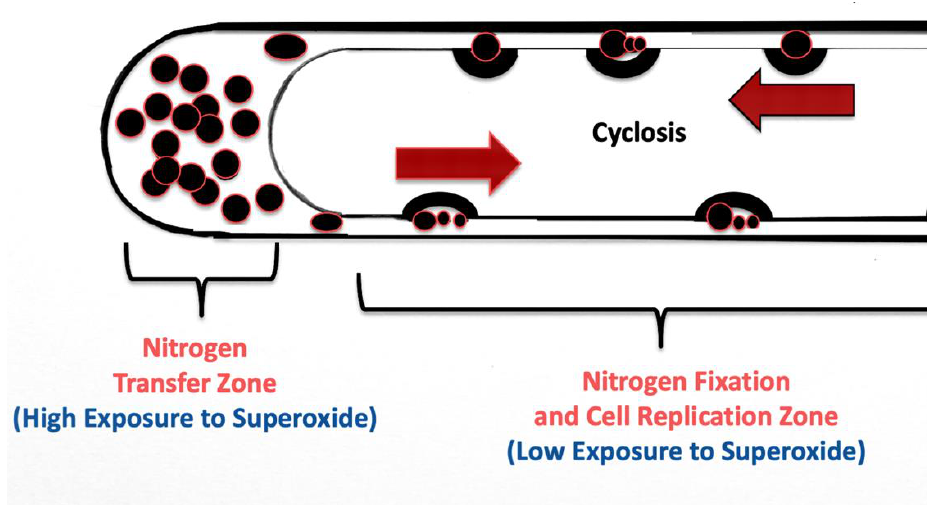
Figure 18. Diagrammatic representation of a root hair showing its differentiation into a nitrogen fixation and microbe replication zone along the hair length, and nitrogen transfer zone in the hair tip. Lack of movement of microbes in the tip of the hair results in a maximum exposure to super- oxide and maximum secretion of nitric oxide. Rapid movement of microbes along the lateral walls reduces exposure to superoxide and replicates microbes, facilitating nitrogen fixation by the mi- crobes.